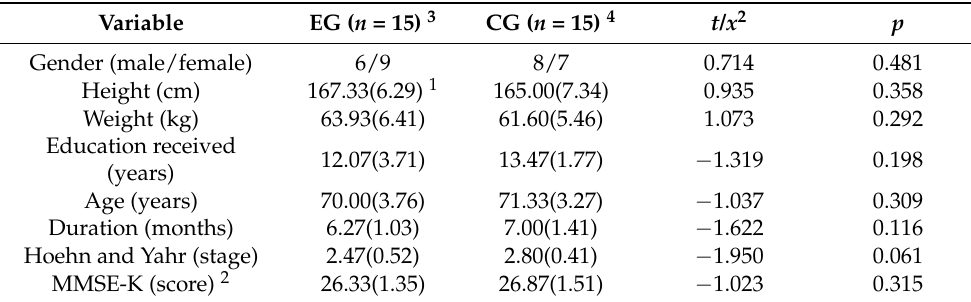
Table 1. General characteristics of the